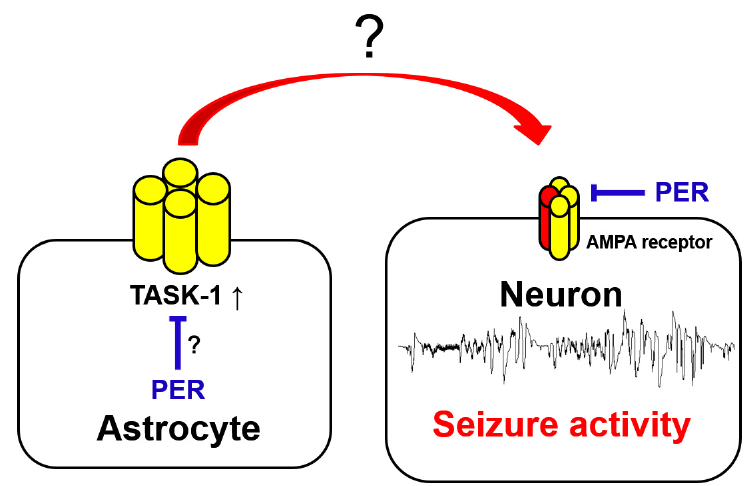
Figure 1. Schematic depiction representing the proposed mechanisms. The present study was conducted to investigate whether PER affects astroglial TASK-1 expression and whether aberrant TASK-1 upregulation diminishes the yield of PER in epilepsy rats. Abbreviation: AMPA receptor, α -amino-3-hydroxy-5-methylisoxazole-4-propionic acid receptor; PER, perampanel; TASK-1, Tandem of P domains in a weak inwardly rectifying K + channel (TWIK)-related acid sensitive K + -1 channel (Red arrow and letters indicate the harmful effects of astroglial TASK-1 upregulation on epileptic seizures. Blue bars or letters indicate the possible inhibitory effects of PER in the epileptic hippocampus. ? indicate the unknown underlying mechanisms of uncontrolled seizures by PER that are investigated in the present study).